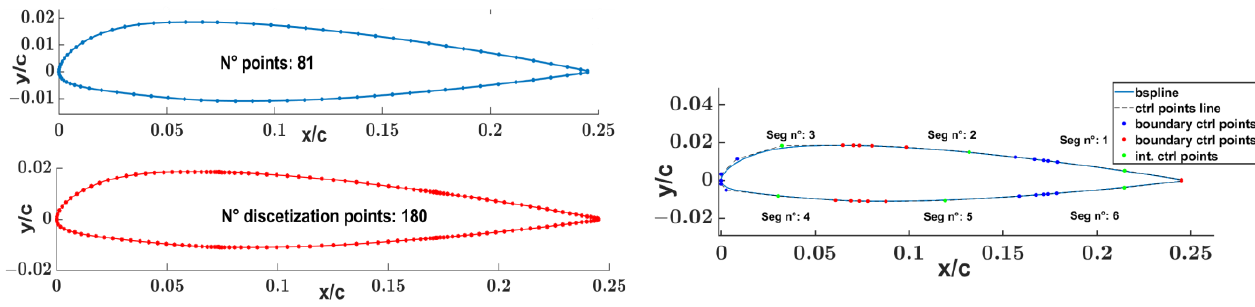
Figure 35. NACA 23012 input airfoil, Mathematical model and discretization.